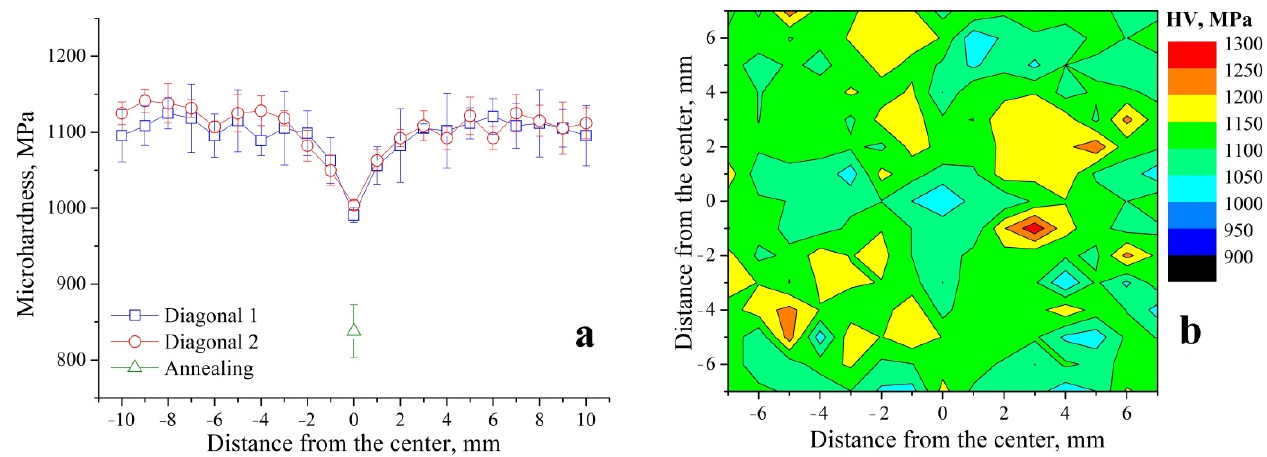
Figure 5. Distribution of microhardness of the alloy over the diameter of the sample after HPT ( a ) and a map of the distribution of microhardness over the surface of the sample after HPT ( b ). Table 3. Mechanical properties of the Zn-1%Mg-0.1%Ca alloy in the initial state and after HPT processing. State